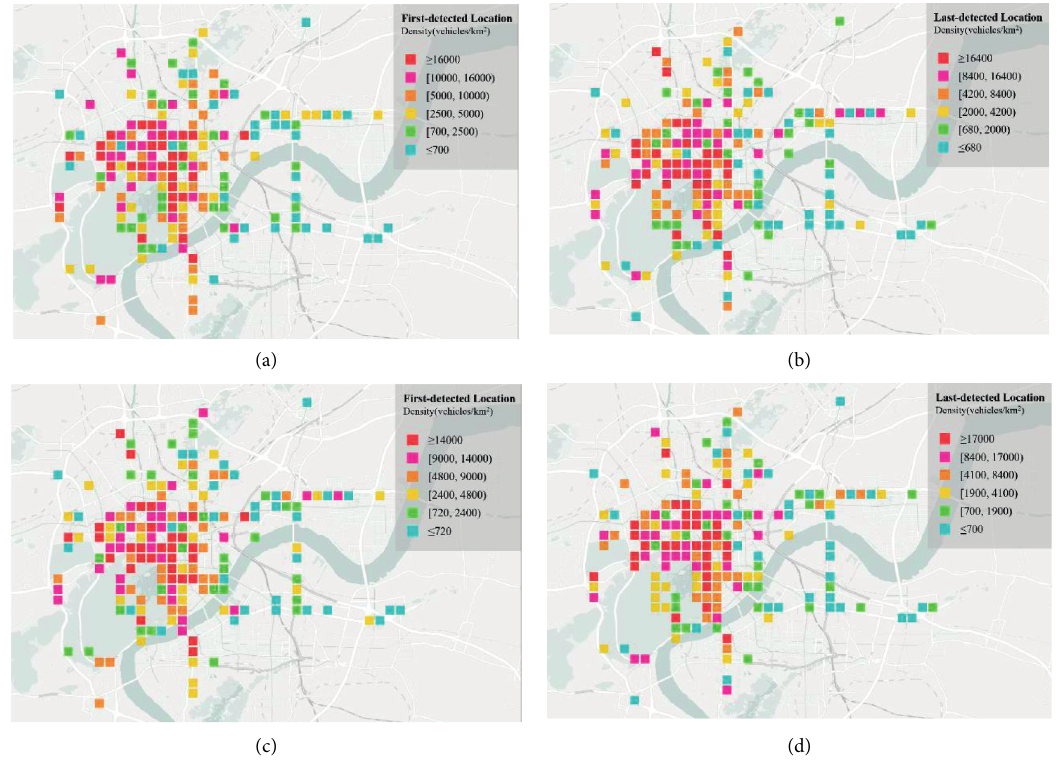
Figure 4: The first and last detected location distribution during the morning and evening peak hours on weekdays. (a) The first detected location distribution during the morning peak hours on weekdays. (b) The last detected location distribution during the morning peak hours on weekdays. (c) The first detected location distribution during the evening peak hours on weekdays. (d) The last detected location distribution during the evening peak hours on